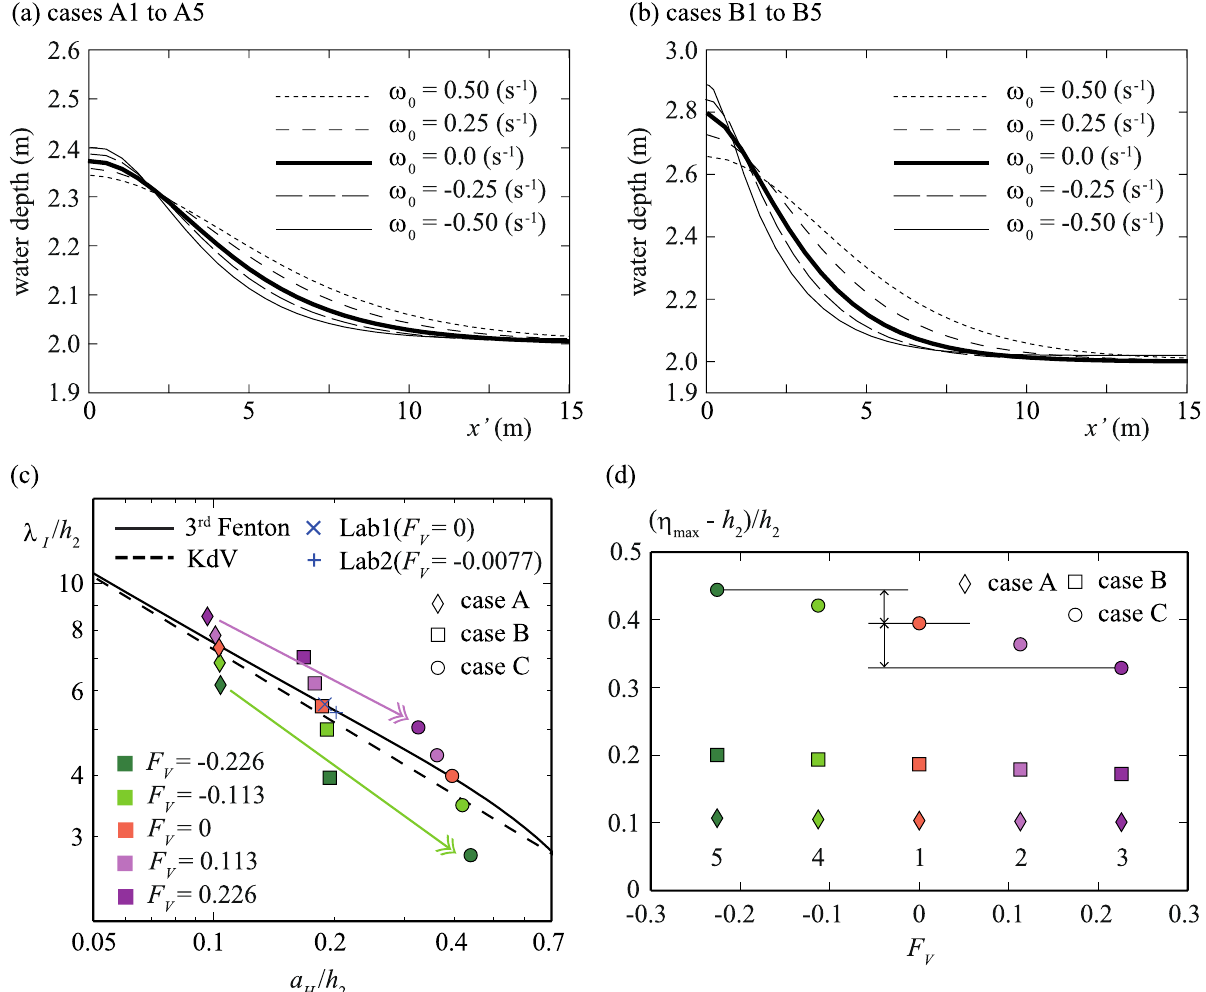
Figure 3. Comparisons of water depth distributions at 20 s. ( a ) Dotted, broken spaced, thick solid, broken, and thin solid lines indicate cases B3, B2, B1, B4, and B5, respectively. ( b ) Dotted, broken spaced, thick solid, broken, and thin solid lines indicate cases C3, C2, C1, C4 and C5, respectively. ( c ) (cid:31) I for theoretical solutions and the Nakayama model at 20 s. Broken and solid lines indicate the KdV solution and the 3rd-order solution by Fenton 39 for surface waves. ( d ) Froude number, F V , and the normalized maximum wave height, (η max for cases A, B, and C at 20